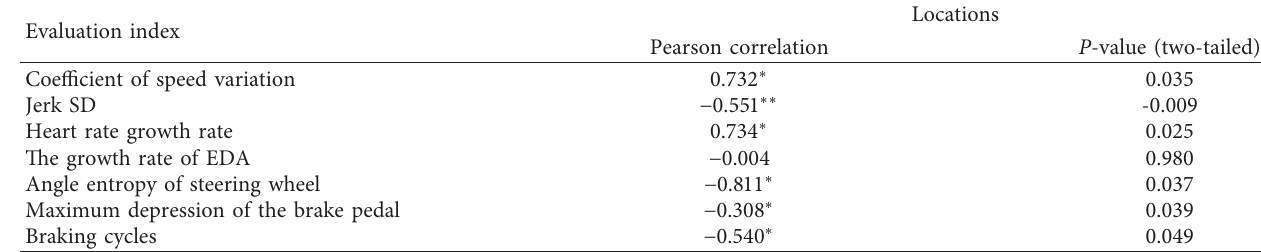
Table 2: Correlation analysis